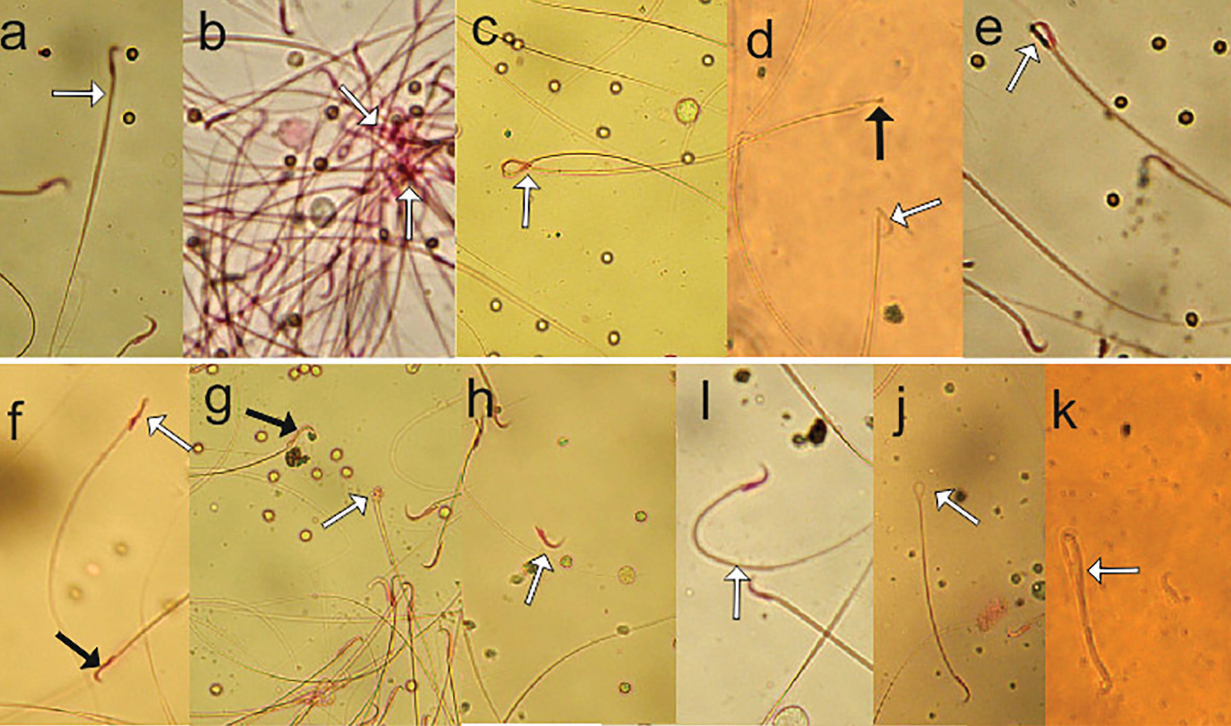
FIGURE 3 - Microphotographs illustrating morphologically normal sperm (a) and various sperm defects (b-K).{b, Sperm agglutination; c, Fused sperm; d, bent head; e, double head; f, hook less head (white arrow) and hook head (black arrow); g, amorphous head (white arrow) and banana head (black arrow); h, tailless head; I, sperms with bent mid piece; j, coiled tail; k, looped